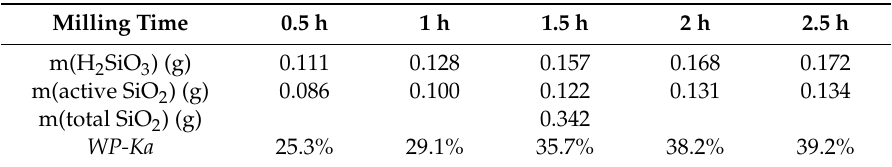
Table 8. Percentage of active SiO 2 of CP.